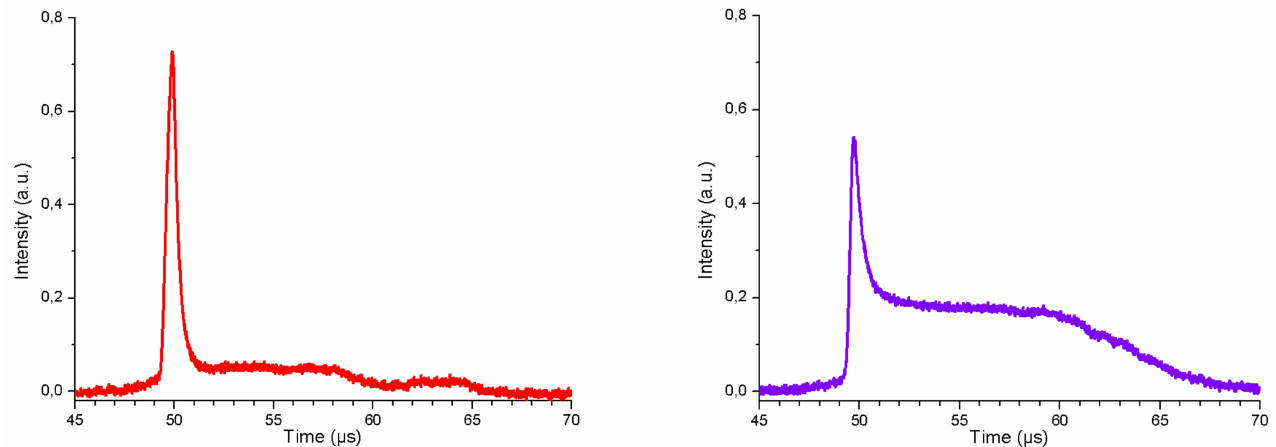
Figure 56. Emission intensity as function as time for Case 2 of Table 6: Left CO(4+) 156–154 nm; Right: CN(violet) 381–389 nm (from [55]).